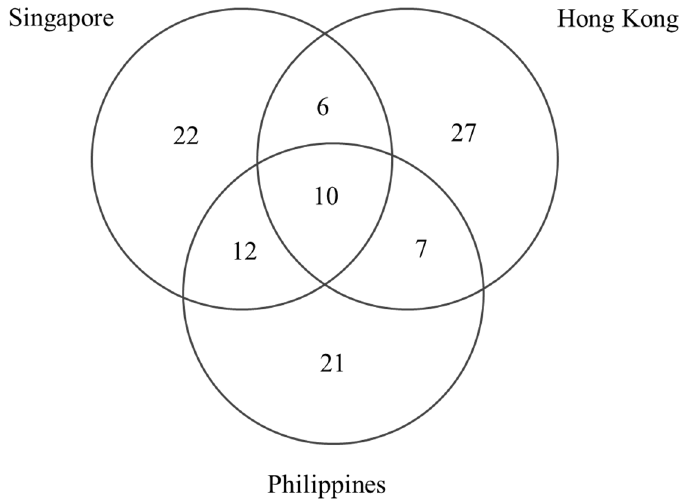
Figure 1. Distribution of 50 URLs retrieved for each location, showing number of URLs retrieved for one, two, or all three locations, resulting in 105 unique URLs.